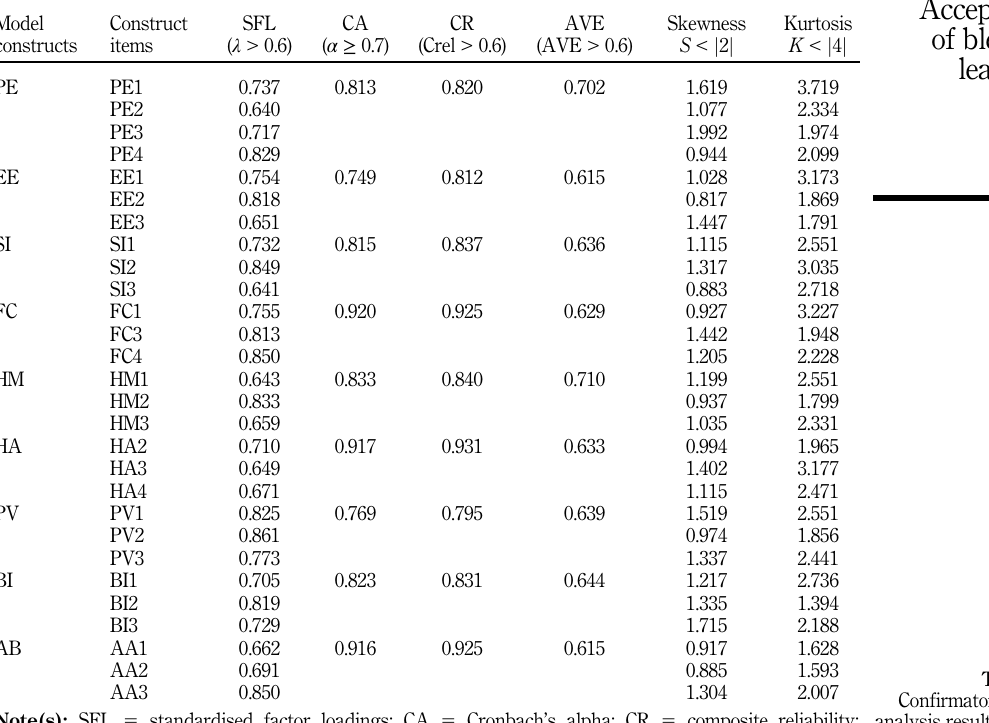
Table 3. Confirmatory factor analysis results ( λ , CA, CR, AVE, S and K